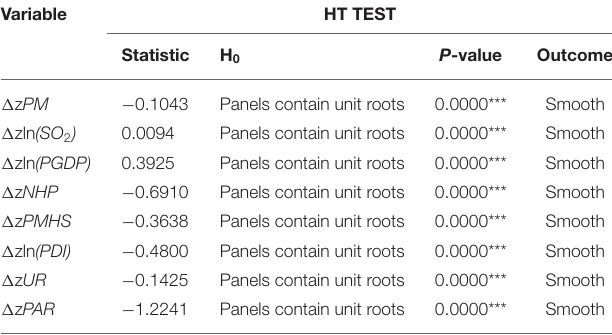
TABLE 2 | Unit root test.